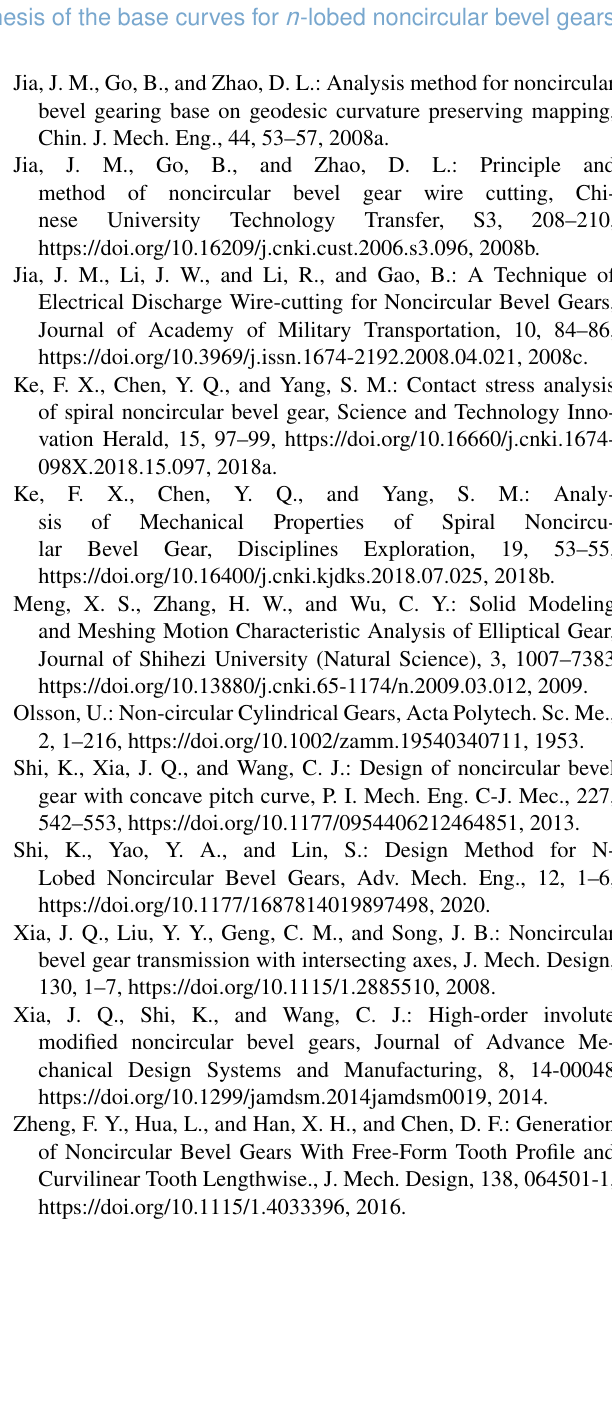
Figliolini, G., Stachel, H., and Angeles, J.: Base curves of involute cylindrical gears via Aronhold’s first the- orem, P. I. Mech. Eng. C-J. Mec., 230,